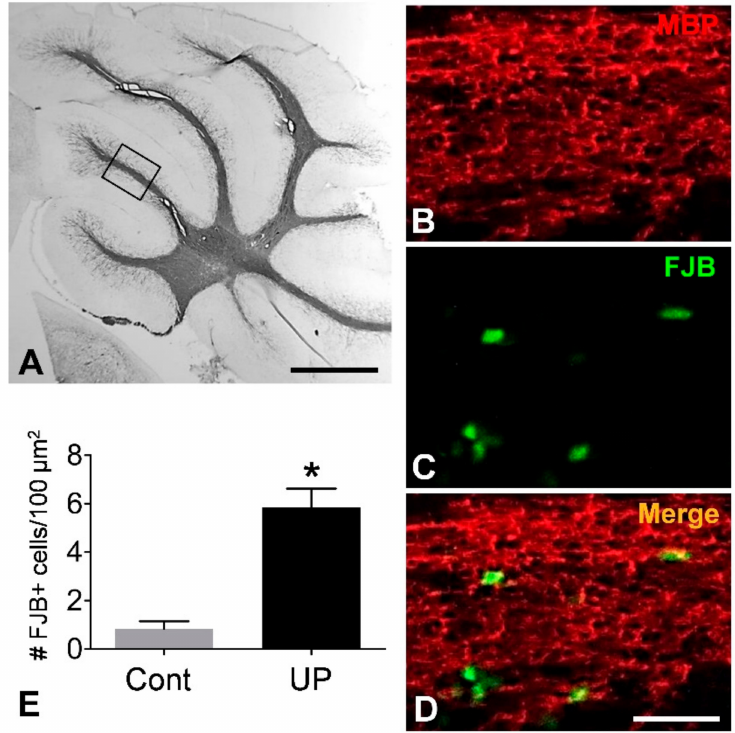
Figure 6. Detection of dead cells in the cerebellar white matter of mice exposed to uf-UPs for 4 weeks. Cerebellar white matter is labeled with an anti-MBP antibody ( A ). The white matter in the cerebellar folium (shown in the box in panel A ) contains Fluoro-Jade B (FJB)-positive cells ( B – D ). The number of FJB-positive cells in the uf-UP exposure group (UP) is significantly higher than in the control group